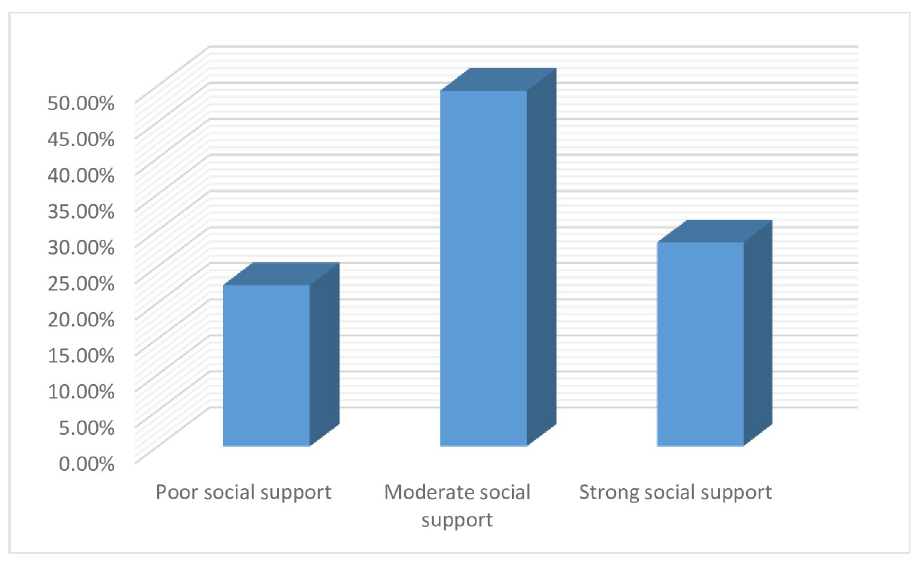
Fig 1. Social support of adult cancer patients.